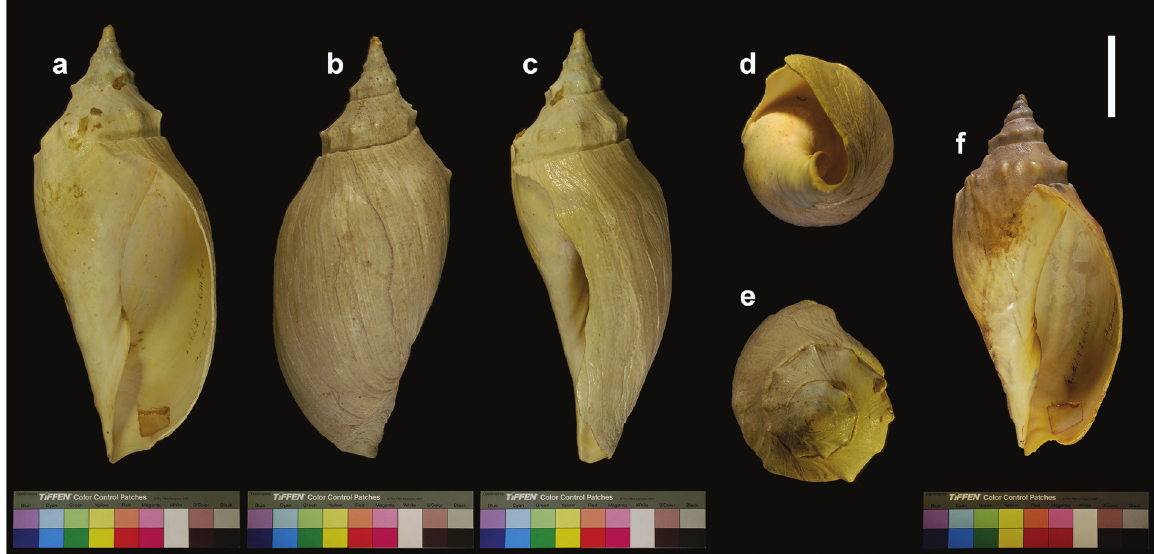
Figure 39. Voluta fusiformis connexa . a–e Specimen figured by Lahille (1895: pl. III, fig. 20) a Apertural view b Dorsal view c Lateral view d Umbilical view e Apical view f Specimen figured by Lahille (1895: pl. III, fig. 19) in apertural view. Scale bar: 5